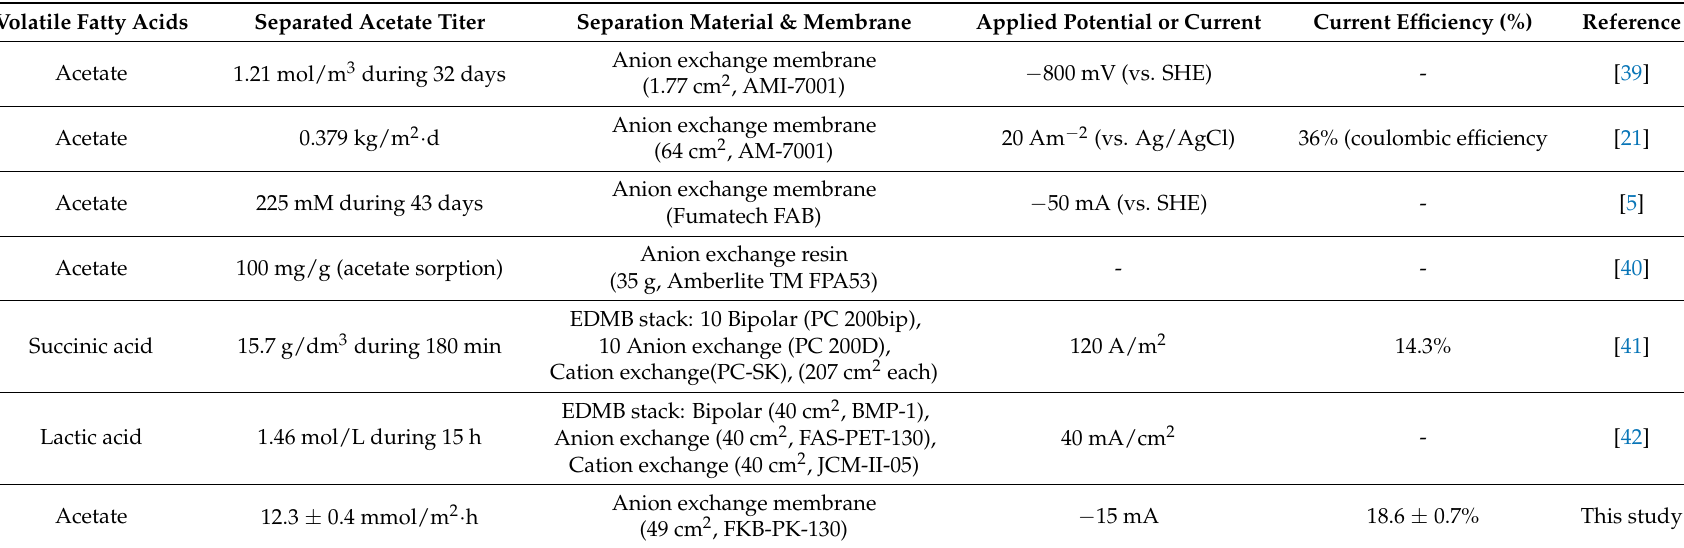
Table 2. Volatile fatty acid separation using various ion exchange membranes and